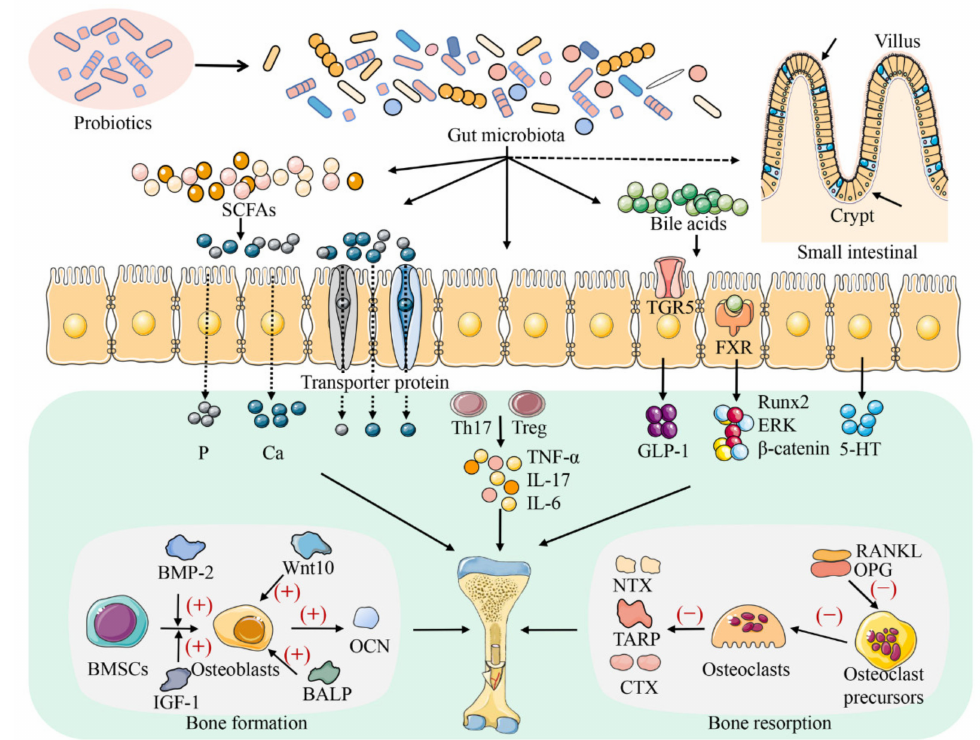
Figure 2. The regulatory mechanism of probiotics on bone metabolism. Probiotics affect the growth and development of bone by regulating the composition and function of the gut microbiota. Probiotics can maintain bone homeostasis by influencing intestinal nutrients absorption (Ca and P), metabolite production (SCFAs and bile acids), the balance of Th17-Treg cells, the secretion of downstream factors (TNF- α , IL-17, and IL-6), and the secretion of 5-HT in the ‘brain–gut–bone’ axis. Probiotics affect the absorption of nutrients in the intestinal tract mainly by regulating the renewal rate of intestinal epithelial cells and the mode of calcium and phosphorus transport. Furthermore, probiotics also affect bone growth and development by affecting the activity of osteoblastic markers (such as Wnt10, BMP-2, BALP, and OCN) and osteoclastic markers (such as OPG, RANKL, TRAP, NTX, and